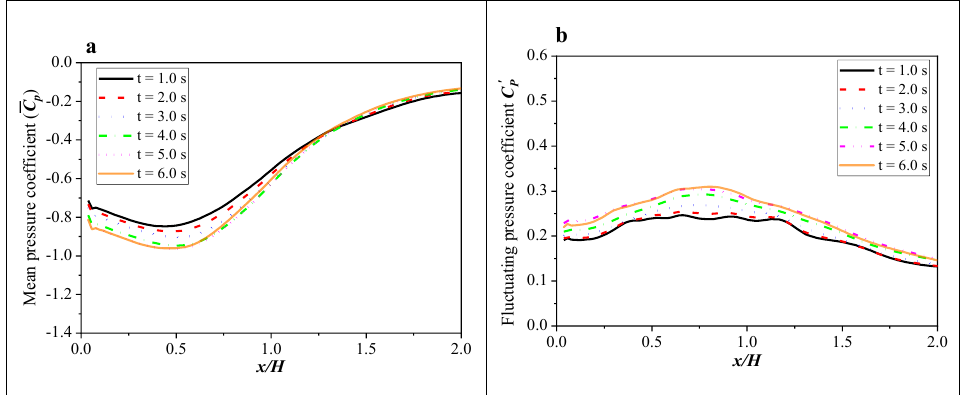
Figure 6. The influence of different sampling times on the statistical values of wind pressure (( a ) Mean pressure; ( b ) Fluctuation pressure).